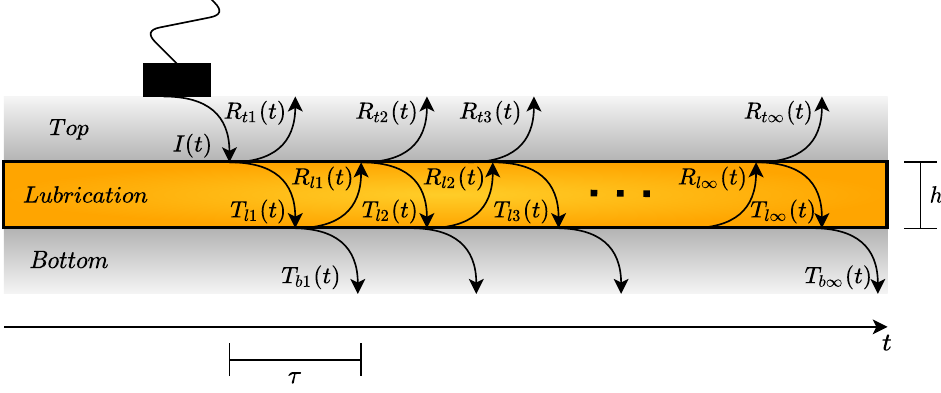
Figure 1. Reflections as an ultrasonic wave propagates through a three-layered